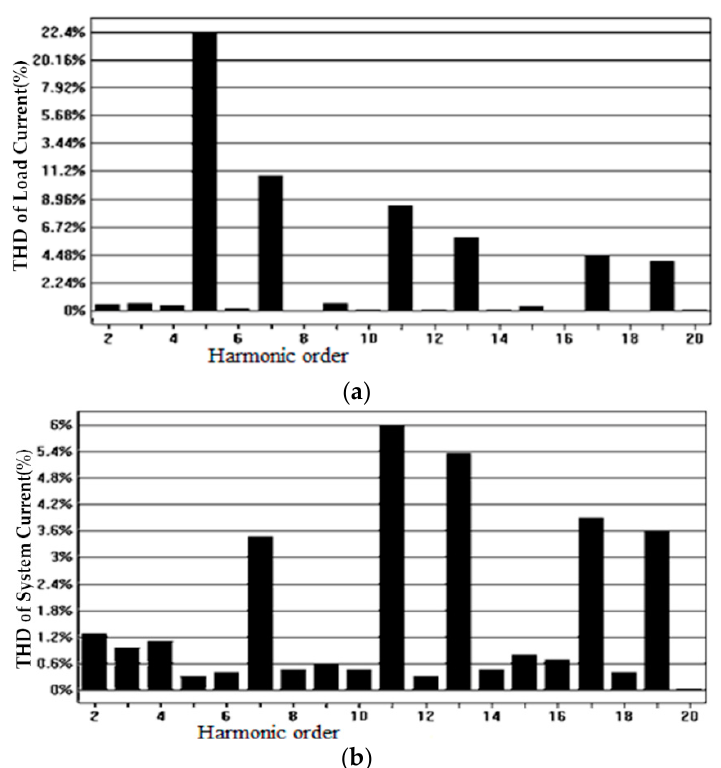
Figure 10. Magnitude spectrum of load current and source current waveforms. ( a )Three-phase uncontrolled rectified load current waveform spectrum before the APF application; ( b )Three-phase system current waveform spectrum after the APF application.